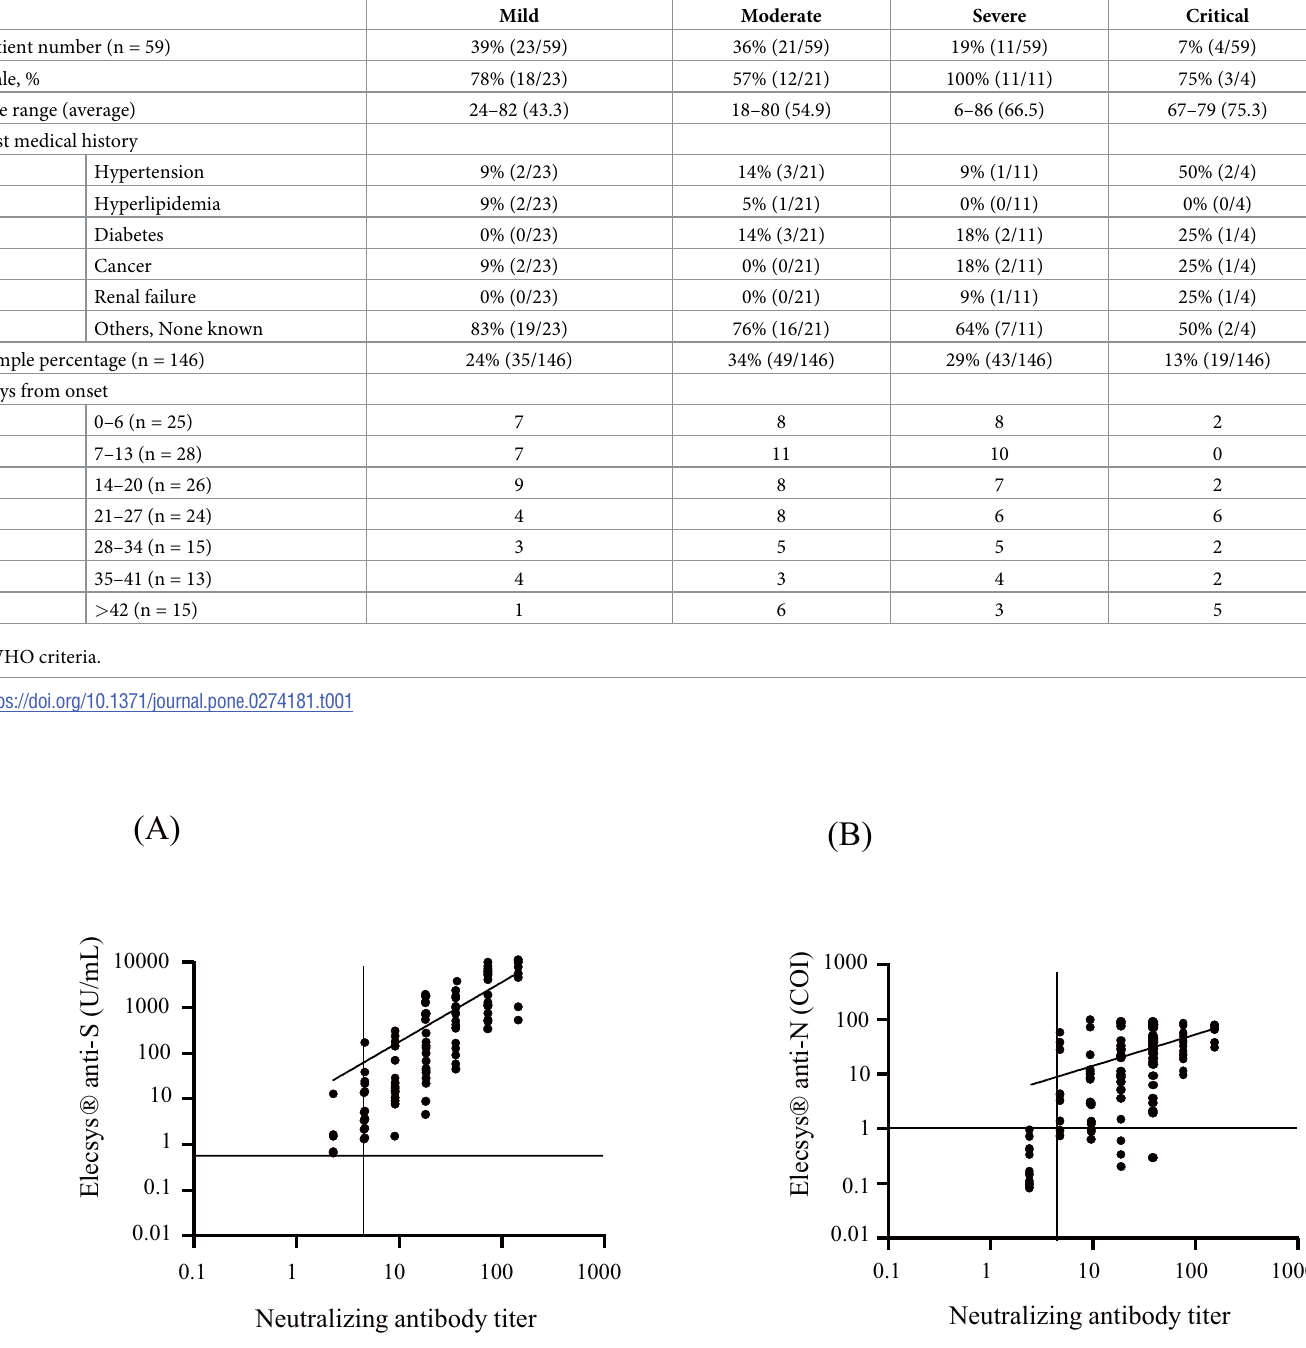
Fig 1. Correlations of Elecsys 1 Anti-SARS-CoV-2 S and Elecsys 1 Anti-SARS-CoV-2 assays results to neutralization assay. One hundred forty-six serum samples from COVID-19 patients were tested by Elecsys 1 anti-S, Elecsys 1 anti-N, and neutralization assay and were examined for correlations. (A) Correlation of Elecsys 1 anti-S and neutralization assay. (B)Correlation of Elecsys 1 anti-N and neutralization assay. Dotted lines represent the manufacturer’s positive cutoff values: Elecsys 1 anti-S, 0.8 U/ml; Elecsys 1 anti-N, COI 1.0; neutralization assay, titer 5. The horizontal axis and the vertical axis are in logarithmic notations. Correlation studies were performed using Spearman’s